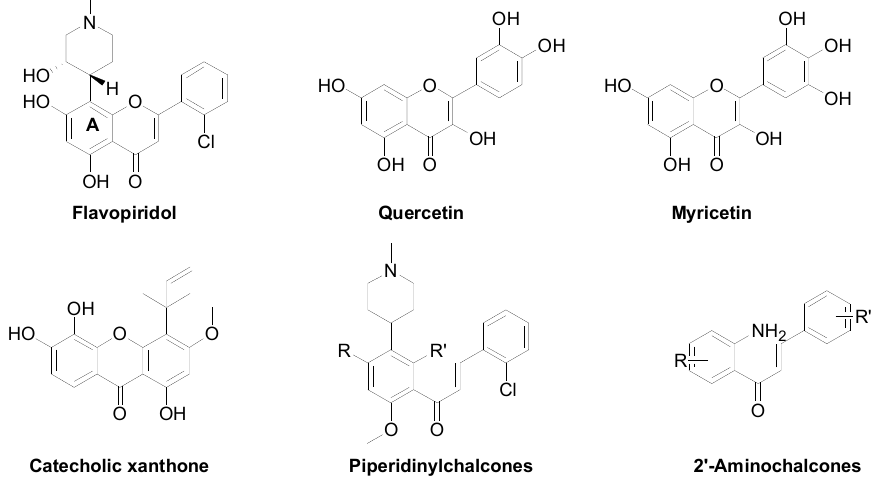
Figure 1. Structures of flavonoids with cytotoxic activity.